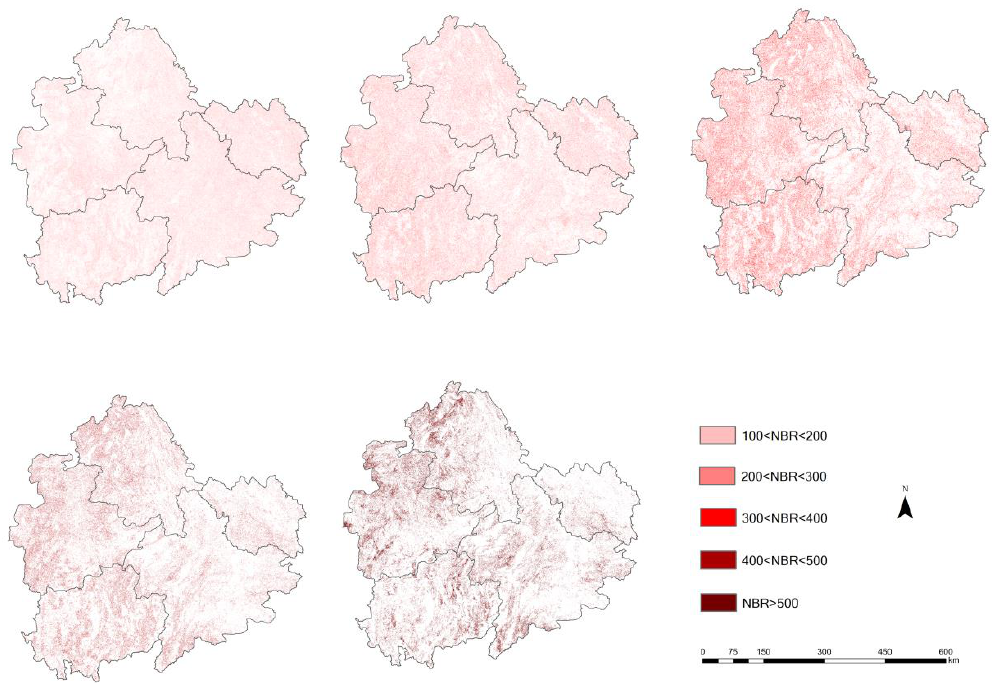
Figure 5. Spatial identification of land use volatility based on different change values of NBR from 2000 to 2018.